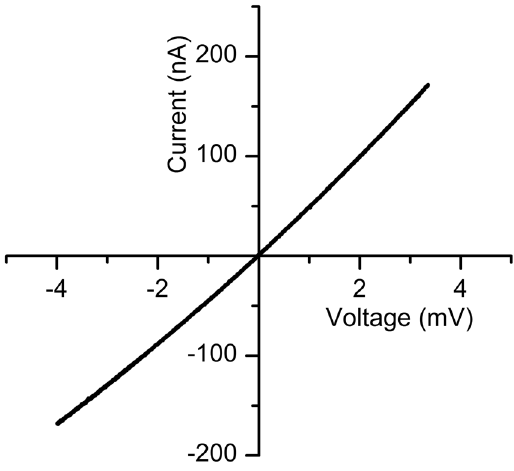
Figure 7. The I-V plot for large populations of lysenin channels inserted into the bilayer lipid membrane. The conductance calculated from the slope of the curve was used to estimate the number of inserted